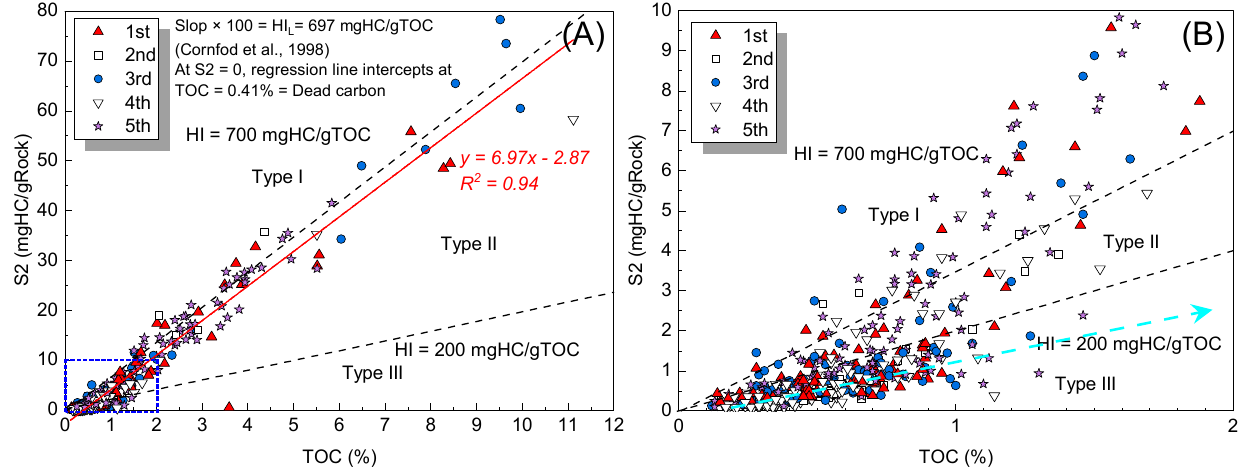
Figure 11. ( A ) S2 vs. TOC plot showing the OM quantity and quality (after [49,50]). ( B ) An enlarged view of the blue box in ( A ).